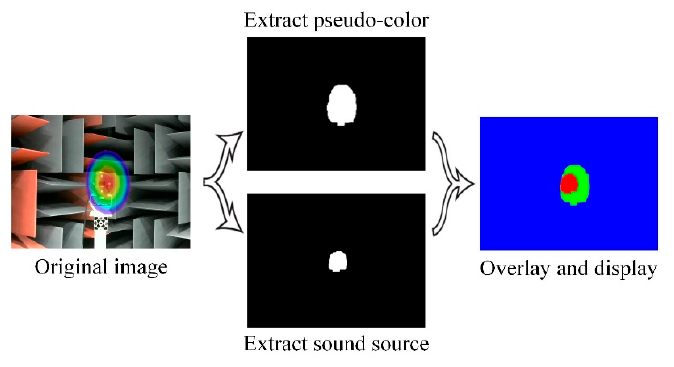
Figure 16. Image processing positioning results.